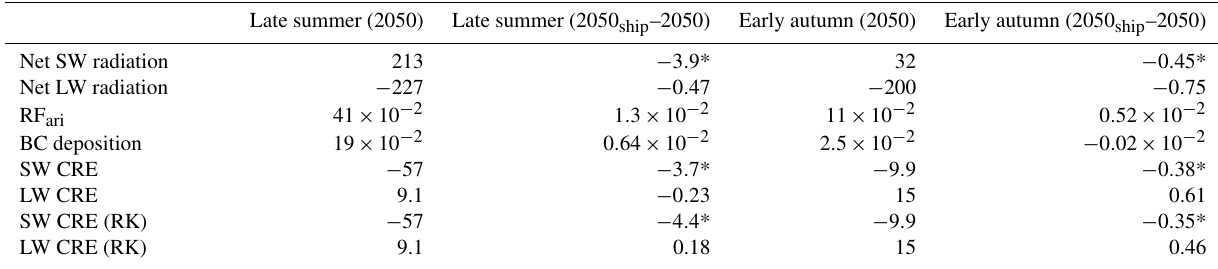
Table 7. The same as Table 6 (impact of additional Arctic shipping) averaged over all latitudes north of 75 ◦